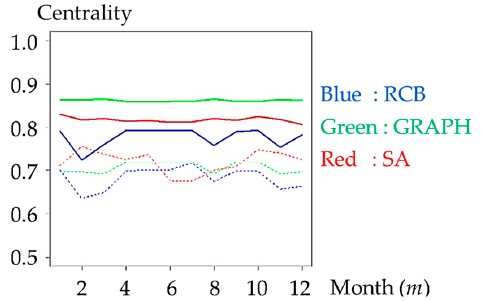
Figure 5. Circularity in each month. The solid lines denote average circularity for all of the clusters in each month, and the dashed lines denote the minimum circularity among the clusters.